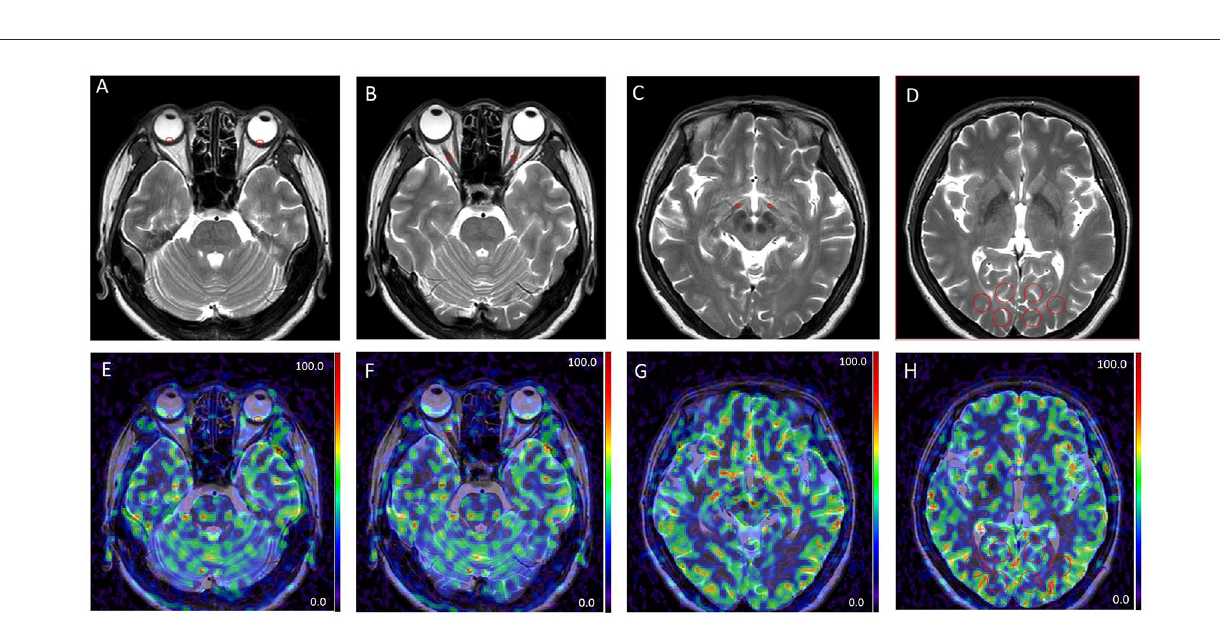
optic nerve ( F = 10.873, p < 0.001; F = 3.907, p = 0.024), the tractus opticus ( F = 13.617, p < 0.001; F = 3.738, p = 0.028), and the visual center ( F = 11.057, p < 0.001; F = 4.012, p = 0.022) (Table 2). Subjects with OIS had the lowest BF perfusion values in the visual pathway at PLD of 1.5 and 2.5 s among the three groups (all p < 0.05).